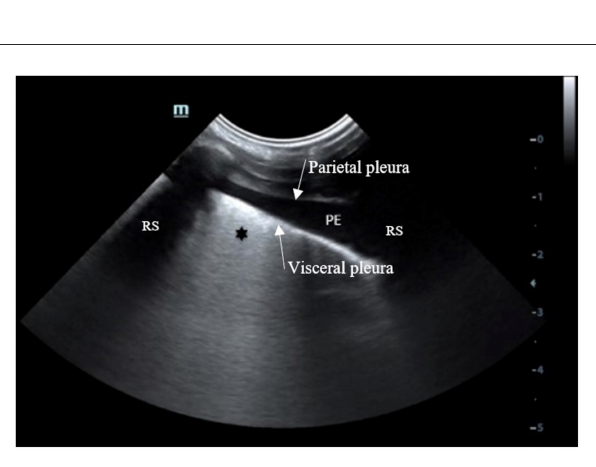
FIGURE4 Thoracic POCUS image with the probe oriented perpendicular between two ribs, located in the lowest part of the thorax of a dog with a presumptive diagnosis of AP with PE. Anechoic free fluid (PE) is identified between the parietal and visceral pleura. The visceral pleura appears thicker with coalescing B lines (*). AP, aspiration pneumonia; PE, pleural effusion; RS, Rib shadow